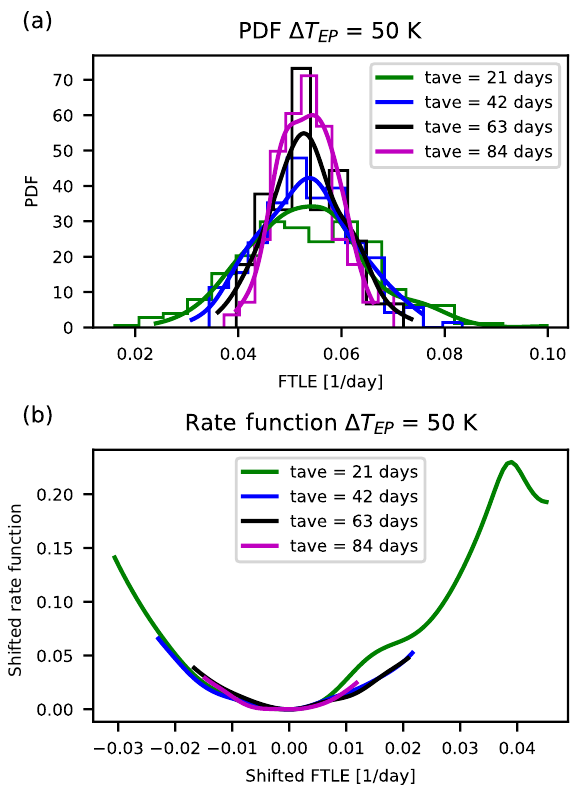
Figure 3. Distributions and rate functions of λ 1 , the fastest-growing instability in PUMA, for (cid:49)T EP = 60K. Panels as in Fig.